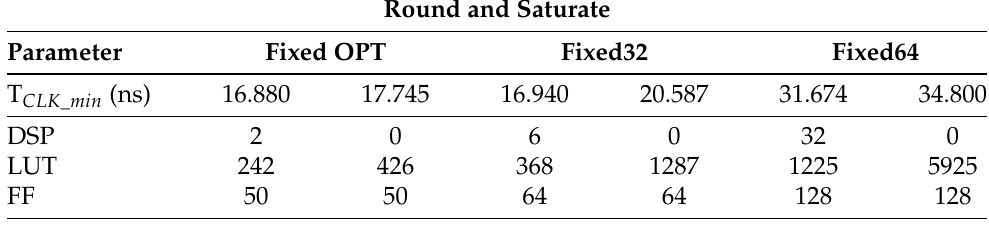
Table 6. Hardware needs in terms of speed (T CLK _ min ) and area (LUTs and FFs) with and without DSPs, for different WLs, as rounding and overflow modes when the fixed-point NF is used in VHDL-2008. Round and